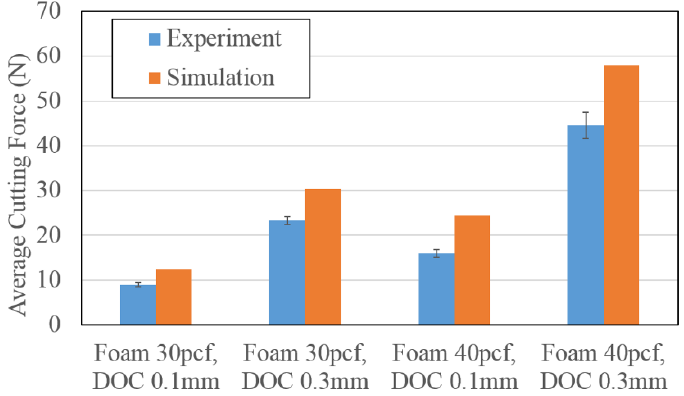
Figure 10. Comparisons between all simulated cutting forces and experimentally measured cutting forces (averaged).